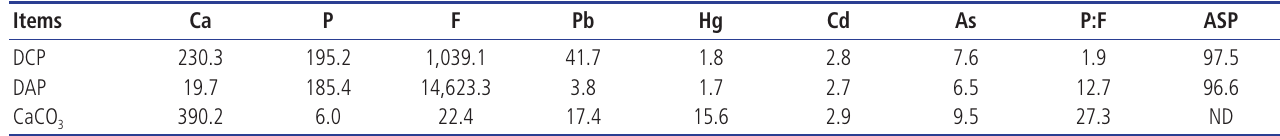
Table 1. Macro mineral (g/kg) and heavy metals (ppm) profile of di-calcium phosphate, di-ammonium phosphate and calcium carbonate used in the experimental diets of finishing lambs Items Ca P DCP CaCO